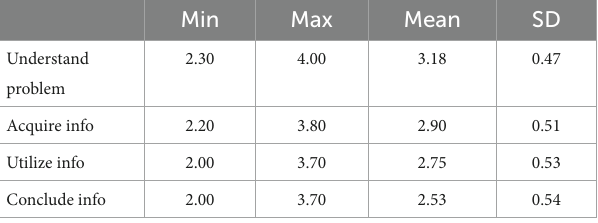
TABLE 3 Academic writing pre-test mean and